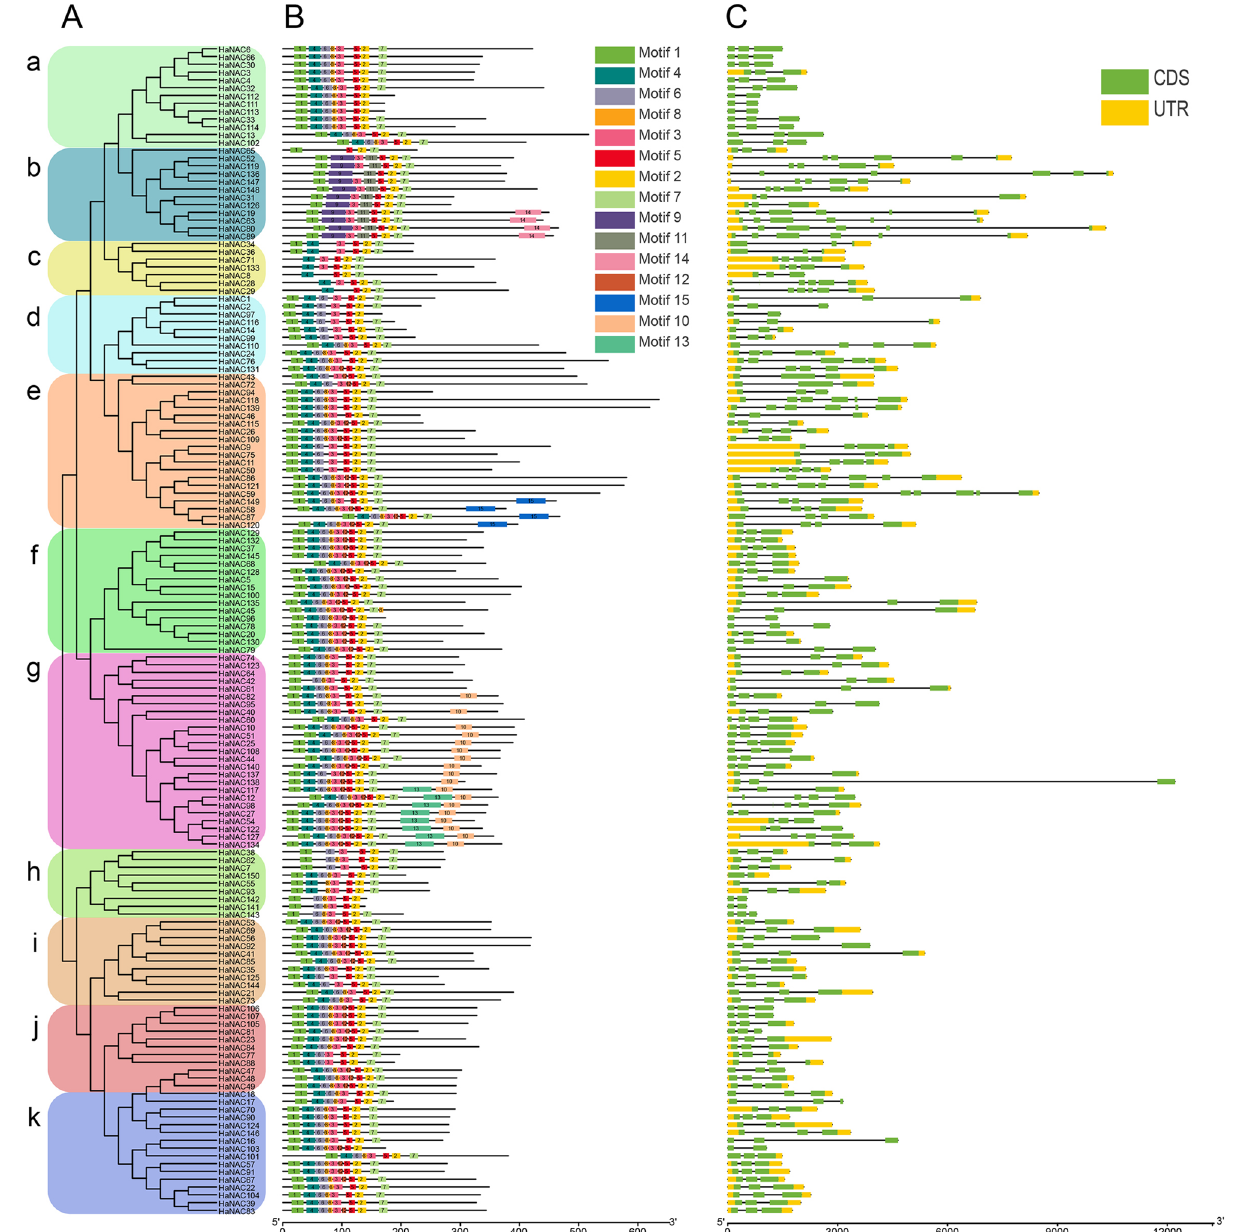
Figure 3. Phylogenetic tree, motif, and genetic structure of 150 HaNAC TFs. ( A ) The phylogenetic tree was constructed using the Neighbor-Joining (NJ) method and 1000 bootstrap tests. ( B ) Showing the positions of 15 motifs in the proteins. Different colors indicated different motifs. ( C ) Gene structures, exons and untranslated regions (UTR) were indicated by green and yellow boxes, and black lines indicated introns. The ruler at the bottom was used to estimate their